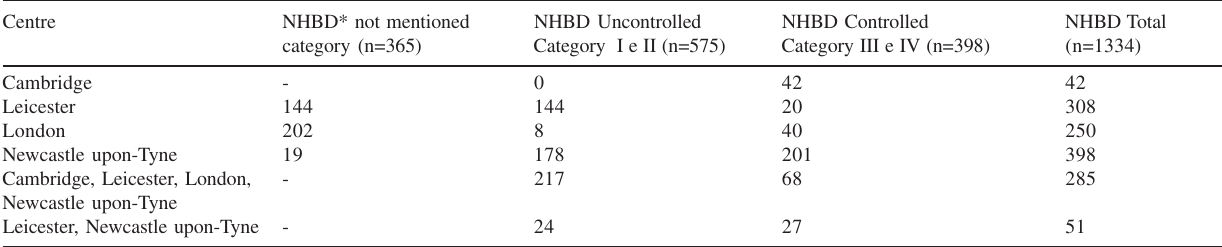
Table 6 - Non-heart-beating donors in England centres according to the Maastricht classification. Centre